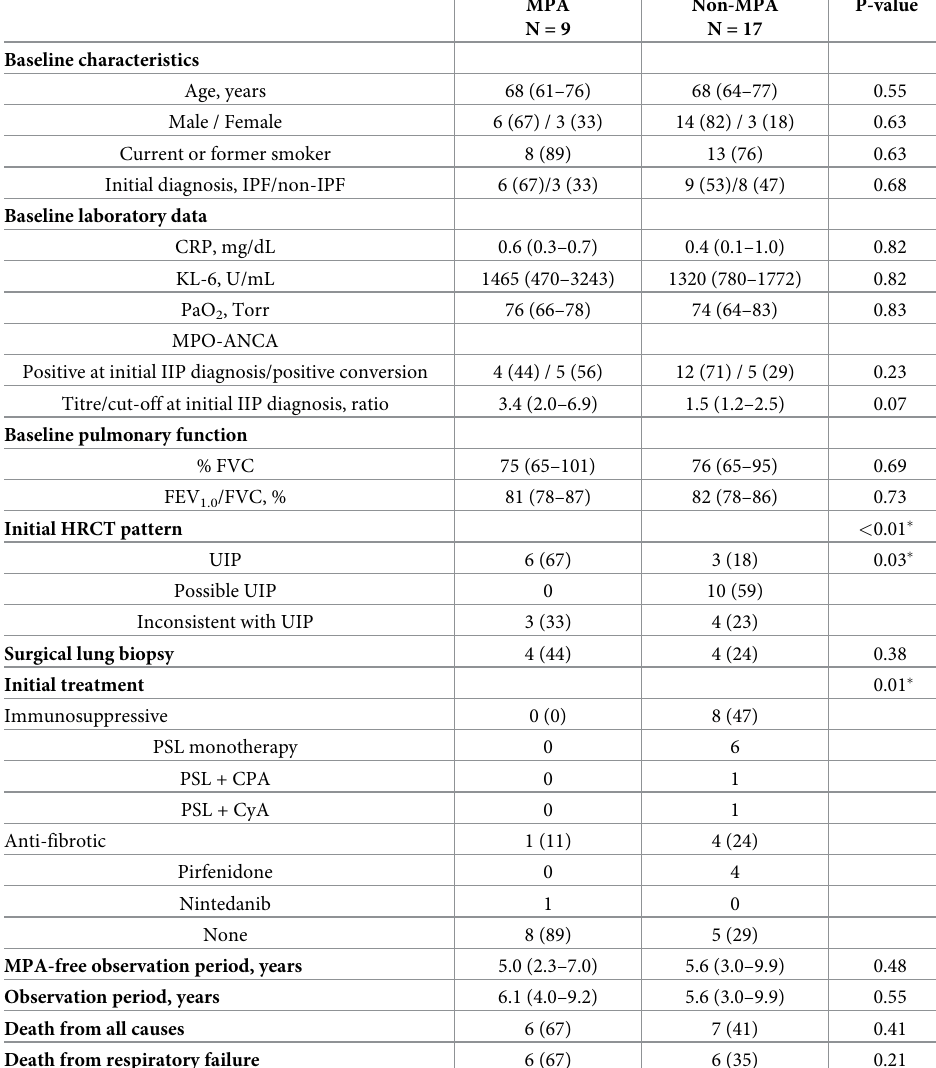
Table 3. Comparison of MPO-ANCA-positive patients according to the development of